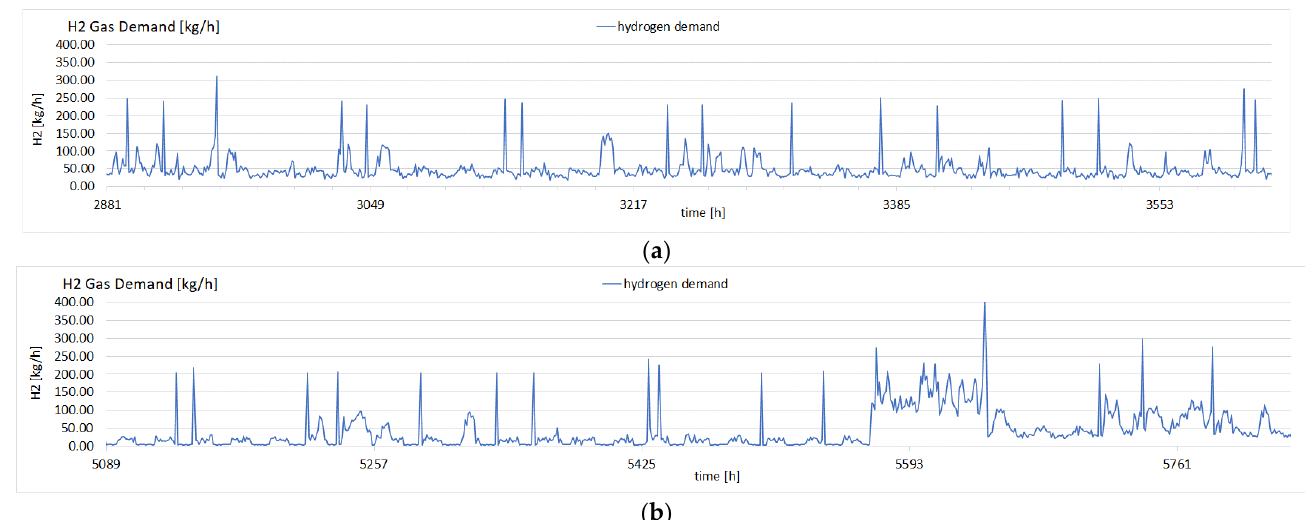
Figure 2. Case hydrogen demand (year 2019, Deventer companies. ( a ) May; ( b ) August.